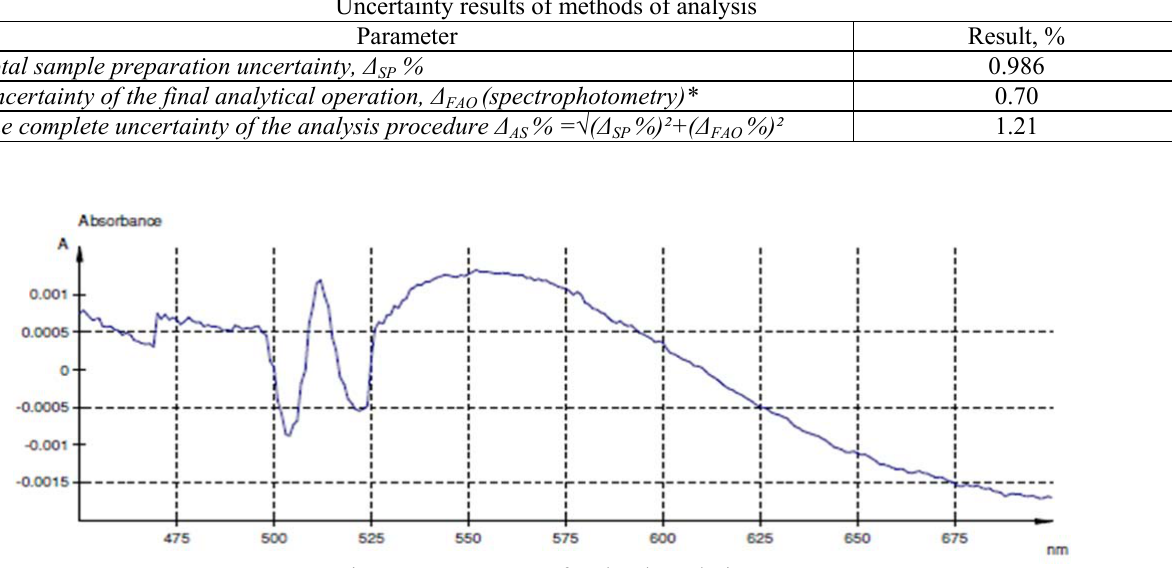
Fig. 2. UV spectrum of a placebo